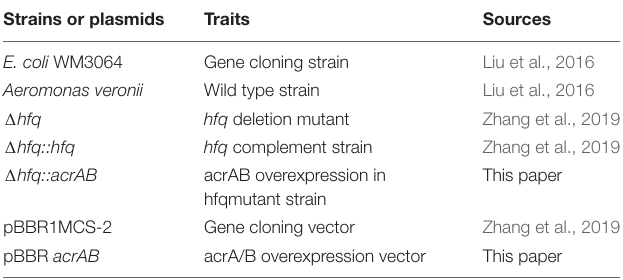
TABLE 1 | Strains and plasmids used in this paper.